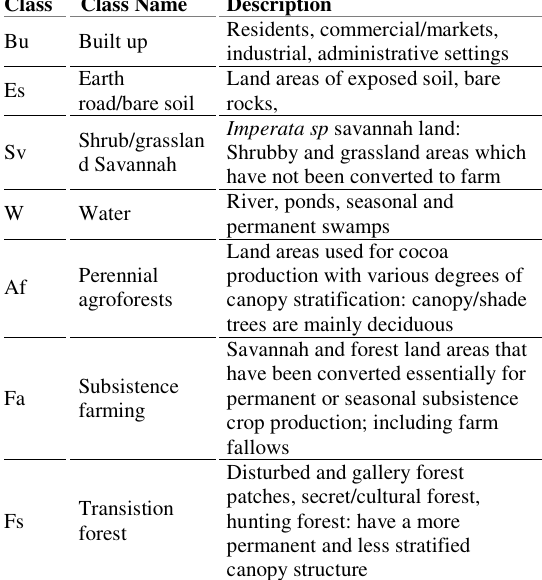
Table 2: Description of the thematic land cover types used for classification of land cover (Figure 2).